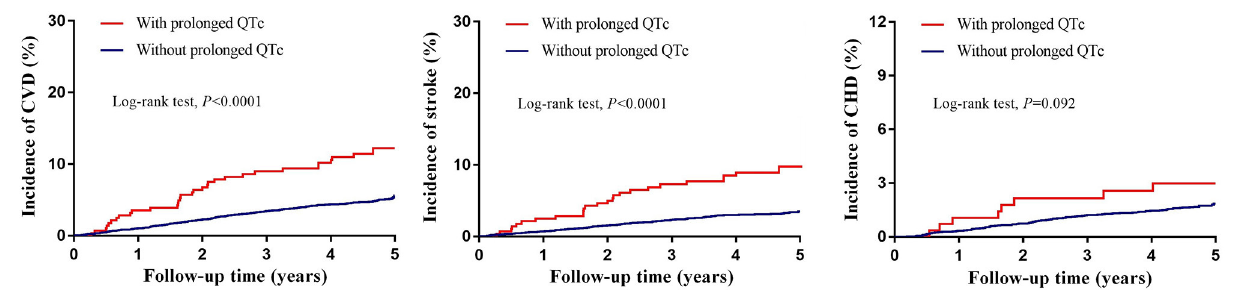
FIGURE 1 | Unadjusted Kaplan–Meier curves for incident cardiovascular events stratified by prolonged QTc interval. CHD, coronary heart disease; CVD, cardiovascular disease. Prolonged QTc interval defined as 460ms or longer in females and 450ms or longer in males using Framingham formula.